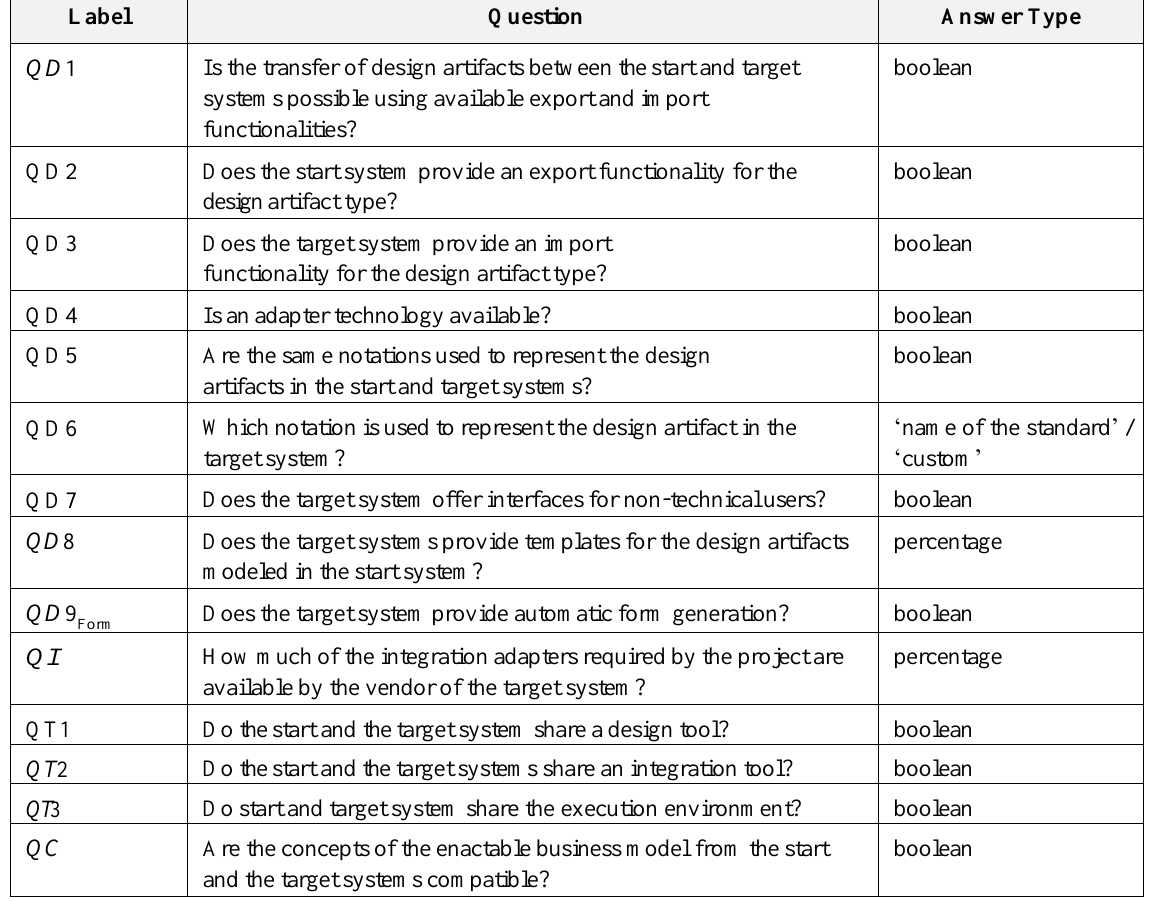
Table 2. Guiding